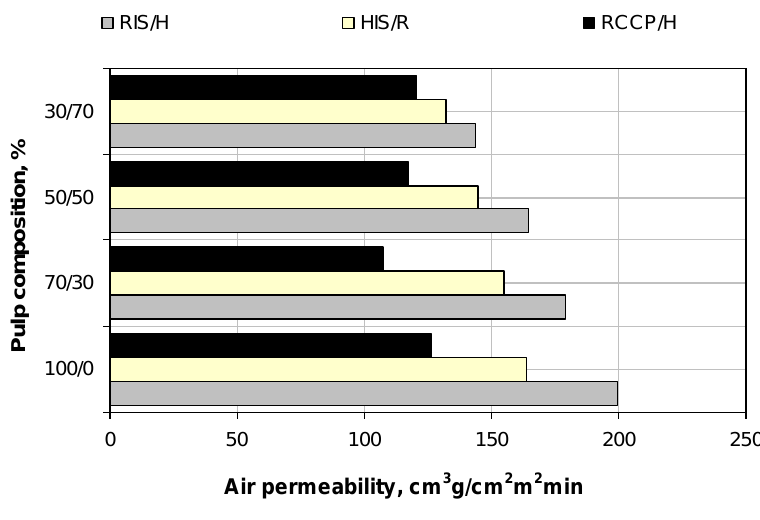
Figure 6. Evolution of air permeability of paper in relation with paper